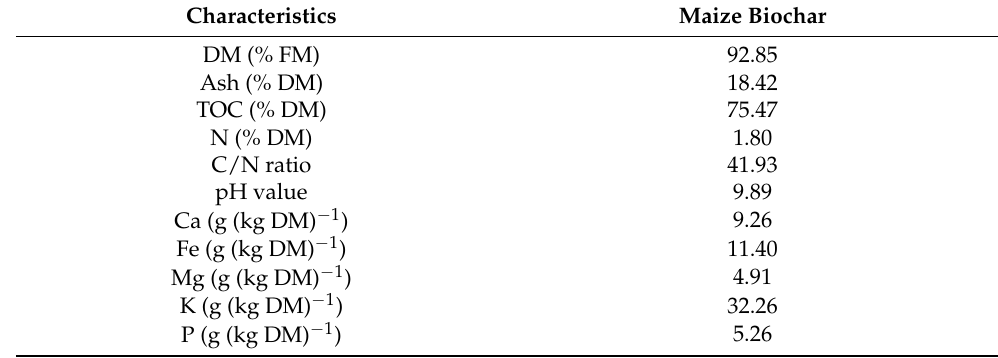
Table 1. Biochar characteristics.